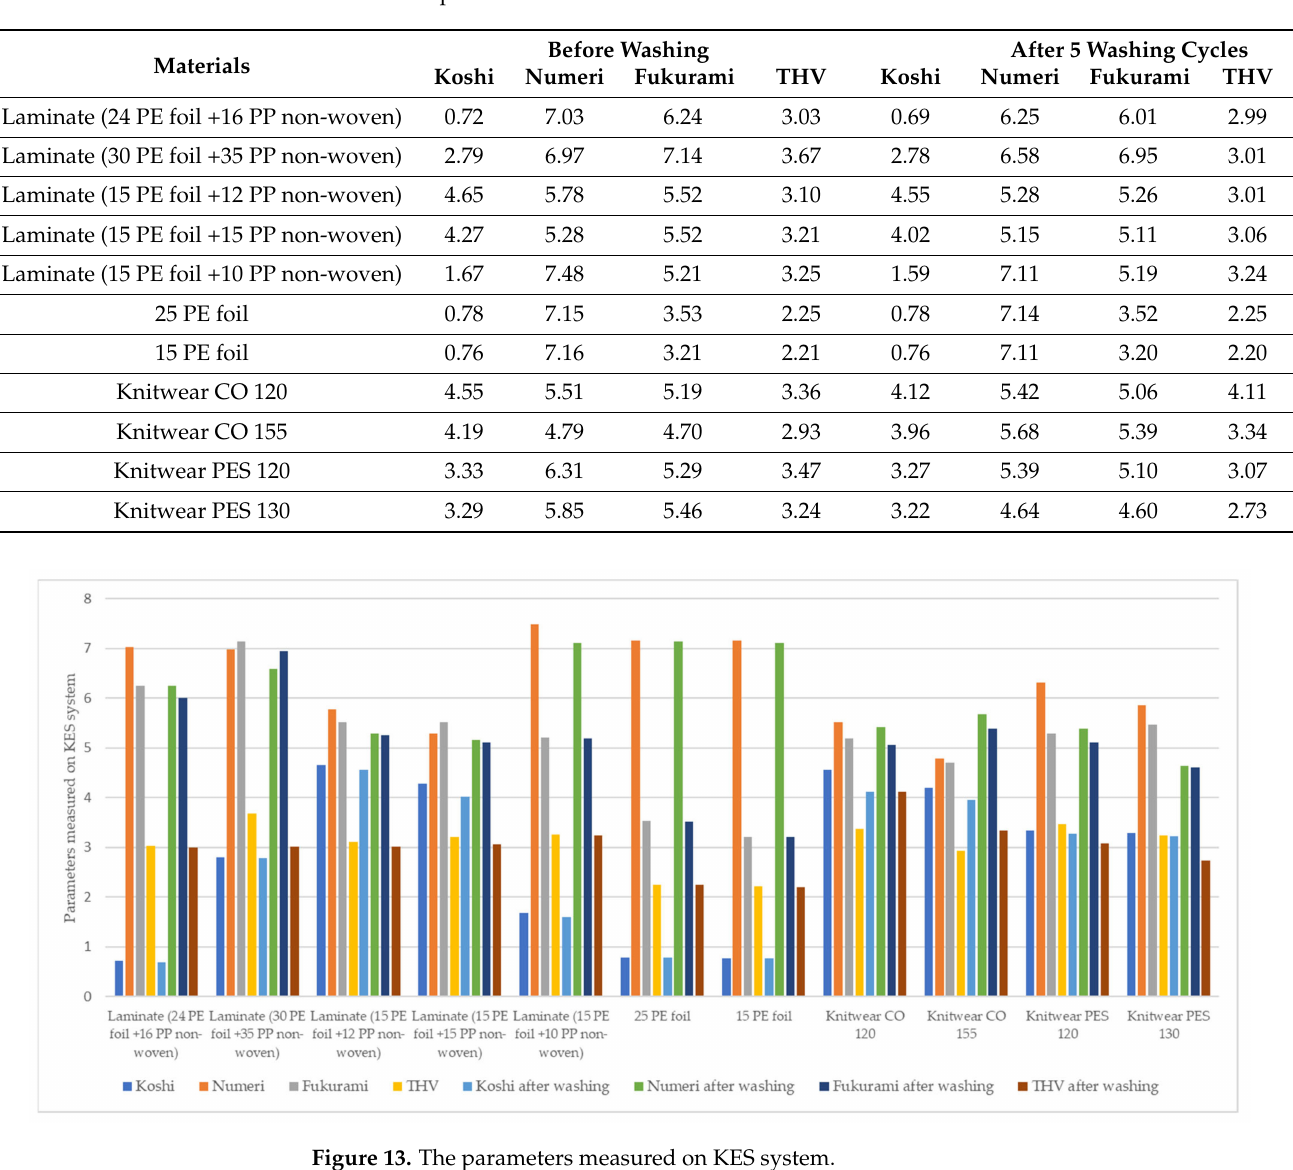
Table 6. The parameters measured on KES device.